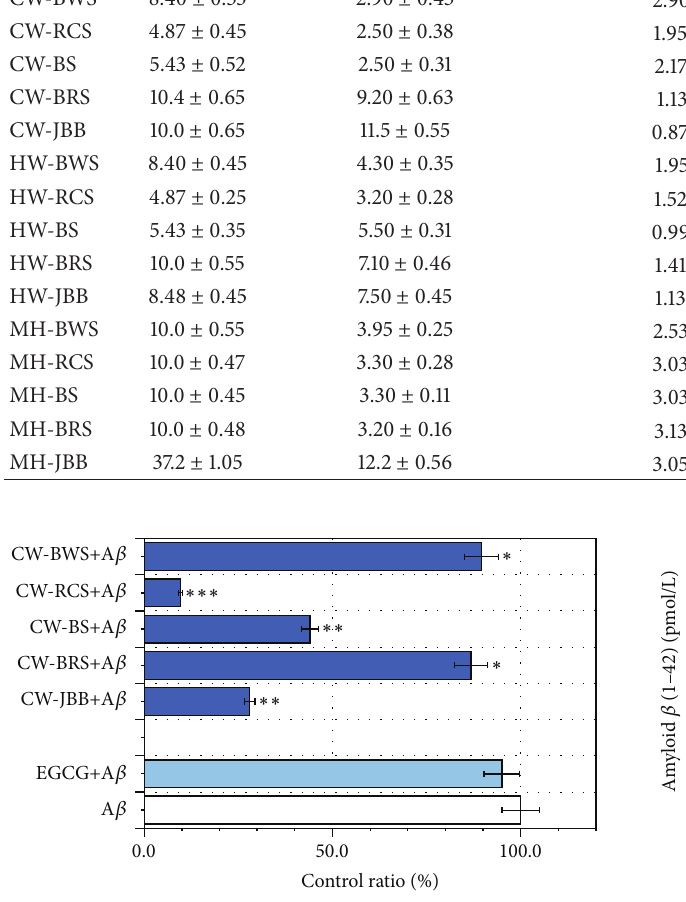
Figure 2: Inhibitory effects of plant sprouts’ aqueous extracts (PSAE) on A 𝛽 (1–42) concentration. Levels of A 𝛽 (1–42) in mixtures (10 𝜇 M A 𝛽 (1–42) 55 𝜇 L and PSAE 55 𝜇 L) were determined with human specific enzyme-linked immunosorbent assay. The mixtures (110 𝜇 L) were added to the microplate wells and then incubated at room temperature for 20h. After 20h incubation, A 𝛽 (1–42) was analyzed with a commercial kit. Values are mean ± SD of the three measurements. ∗∗∗ 𝑃 < 0.001 , ∗∗ 𝑃 < 0.01 , and ∗ 𝑃 < 0.05 compared with the controls.